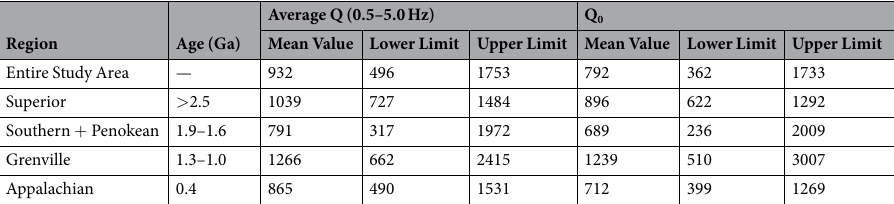
Table 2. Average broadband Q and Q 0 for each geological province, and the entire study